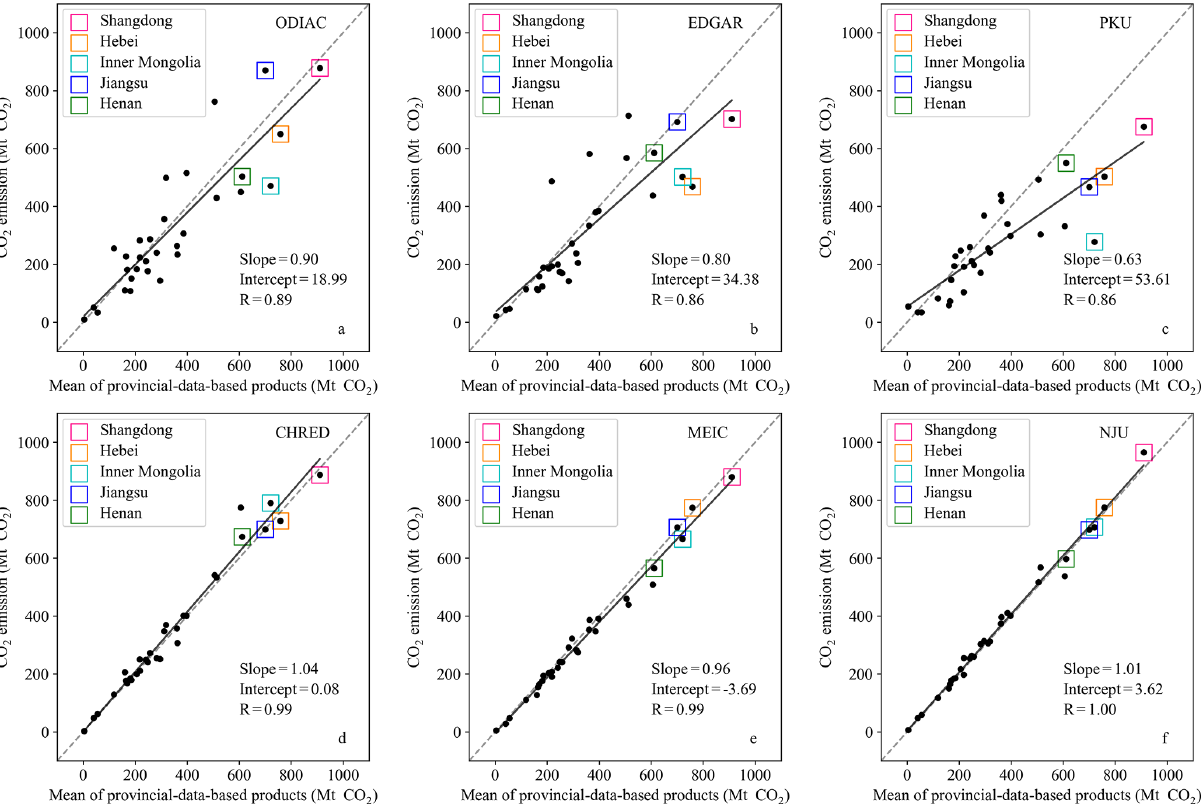
Figure 5. Scatter plots of the provincial total emissions for ODIAC, EDGAR, PKU, CHRED, MEIC, and NJU in 2012 with the five most emitting provinces highlighted, and the x axis is the mean of provincial-data-based products (CHRED, MEIC, and